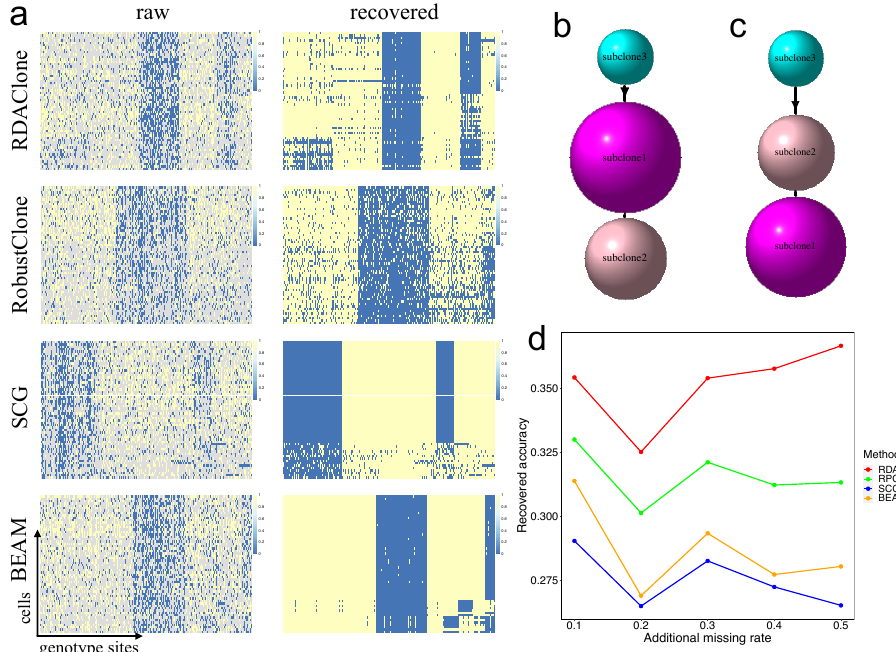
Figure 4. RDAClone works well on ET dataset with a high missing rate. ( a ) The heatmap of raw and recovered genotype matrix for each of methods: RDAClone, RobustClone, SCG and BEAM. The ordering of cells and genotype sites based on the clustering of recovered matrix. ( b ) The evolutionary tree inferred from the recovered matrix by RDAClone. ( c ) The evolutionary tree inferred from the recovered matrix by RobustClone. ( d ) The proportion of missing entries correctly recovered by RDAClone, RobustClone, SCG and BEAM under five sparsity data generated by additional missing